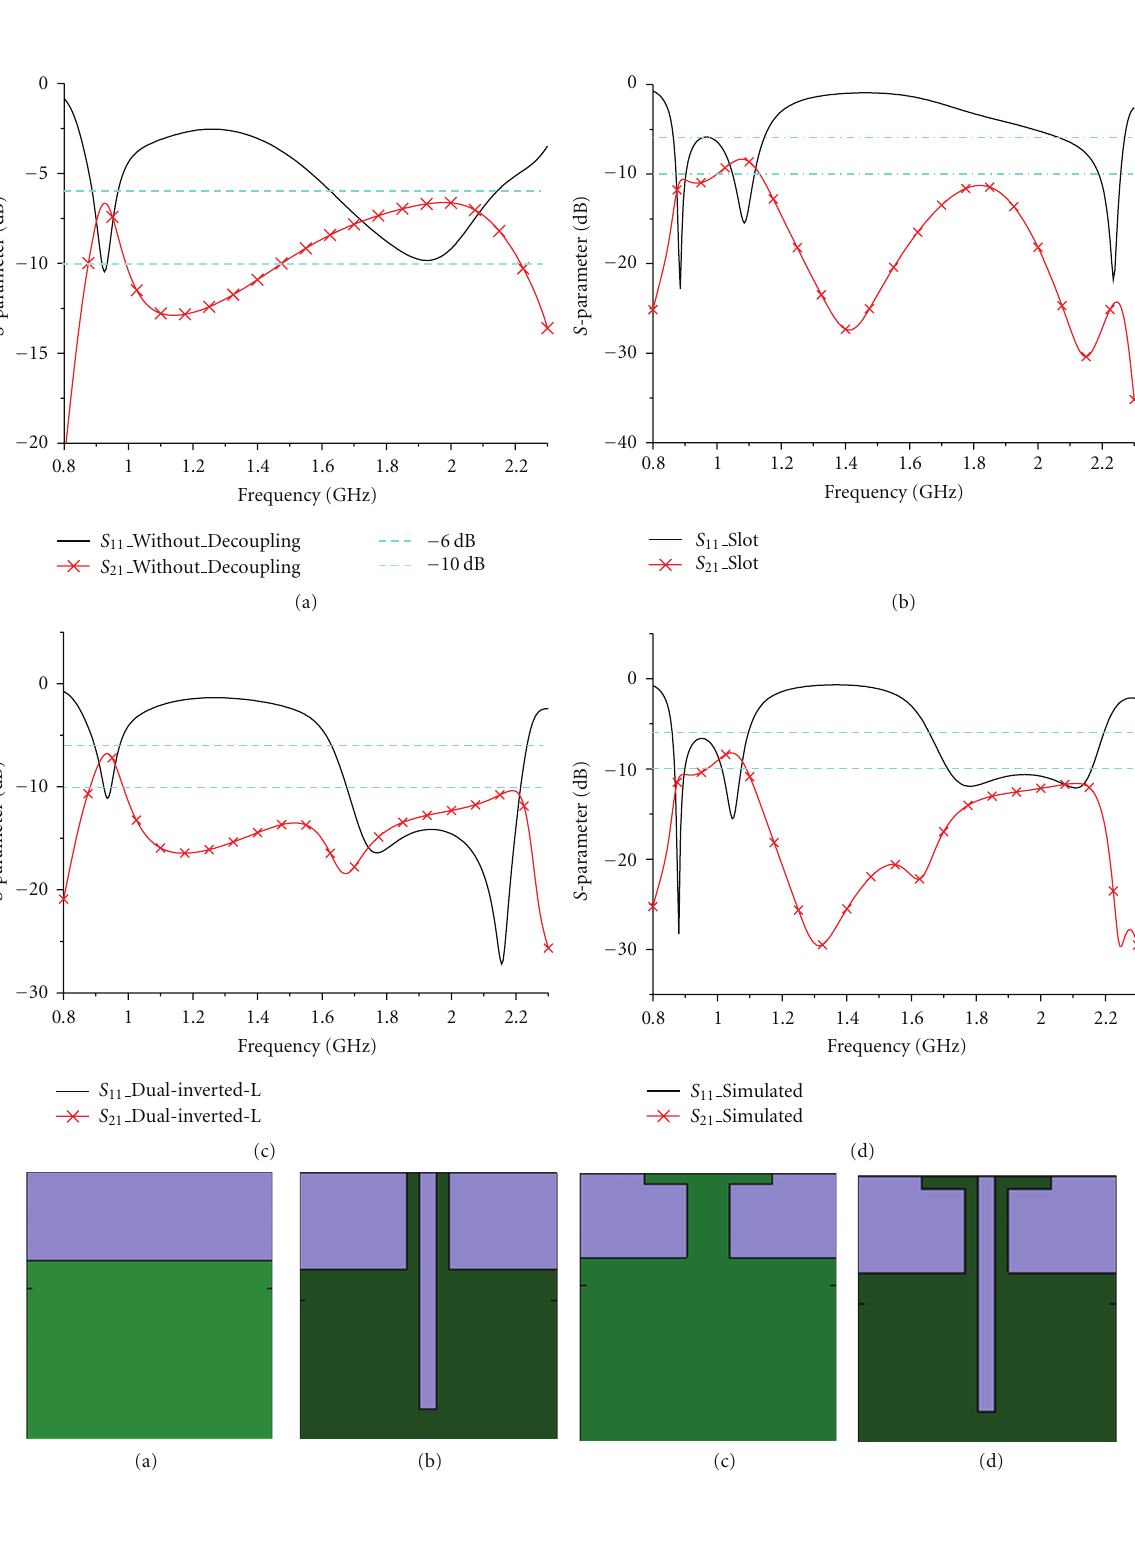
Figure 2: Simulated S 11 and S 21 curves: (a) simulated S -parameter curves of the antenna without slot on ground plane and ground branch, (b) simulated S -parameter curves of antenna with slot on the ground plane, (c) simulated S -parameter of antenna with dual-inverted-L shaped ground branch, (d) simulated S -parameter of antenna with both slot and ground